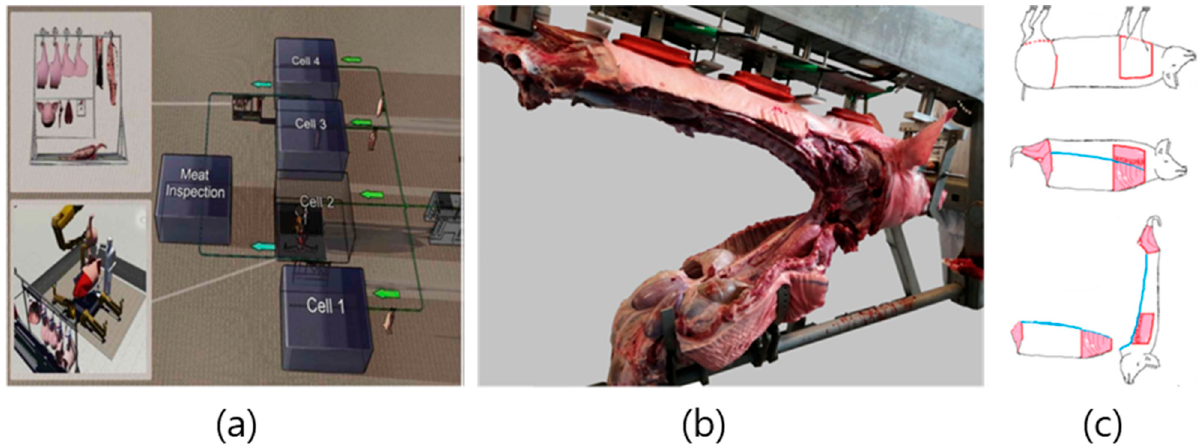
Figure 9. ( a ) The meat factory cell concept [69] (From Valente et al. Life cycle sustainability assessment of a novel slaughter concept. Reprinted with permission of Elsevier, Amsterdam, Copyright © 2020). ( b ) A carcass handling unit: The limbs have been removed, and the belly and ribs sawed approximately 12–15 cm from the spine. The truncus has also been lifted. The trachea, esophagus, and some soft tissue are available for the butcher [67]. ( c ) A schematic of the meat factory cell cutting pattern [67].